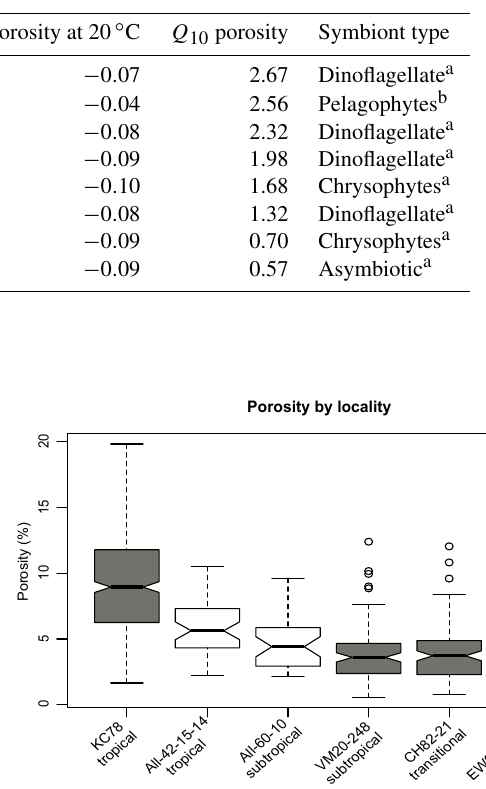
Figure 6. Distribution of size-normalized porosity (%) values in each locality, arranged by latitude from lowest to highest. Grey boxes are samples from which a random split was taken, and white boxes were picked for specific